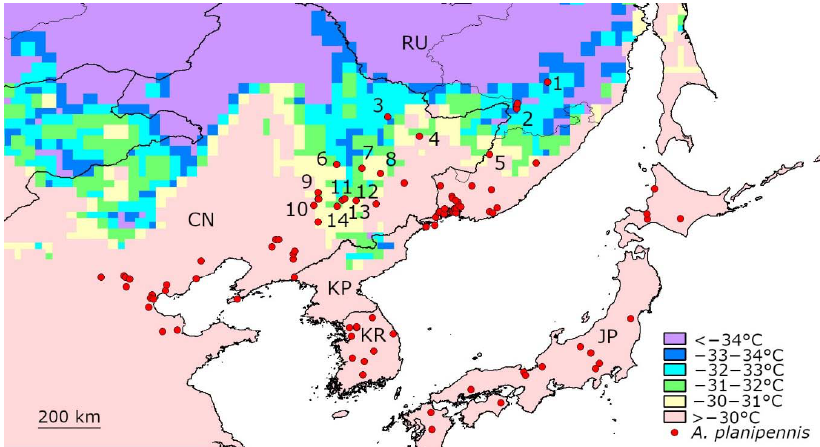
Figure 1. Mean temperature of the coldest day recorded from 2003 to 2019 in the native range of A. planipennis in Asia. Some localities where the daily temperature fell below − 30 °C were numbered. Detailed information for each of these localities is provided in Table 1. CN—China, JP—Japan, KP— Democratic People’s Republic of Korea, KR—Republic of Korea, RU—Russia. Table 1. Temperatures below − 30 °C occurred from 2003–2019 in the localities where A. planipennis populations were recorded during this period *.